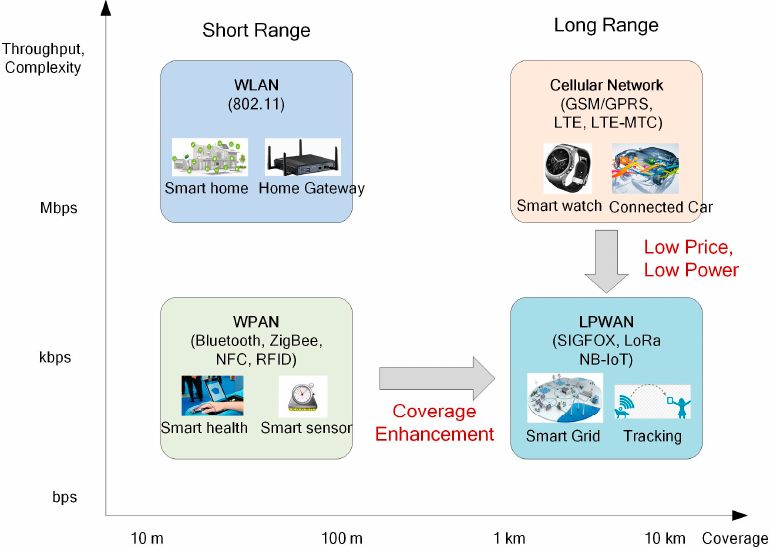
Figure 1. Internet of things (IoT) services according to coverage and throughput.